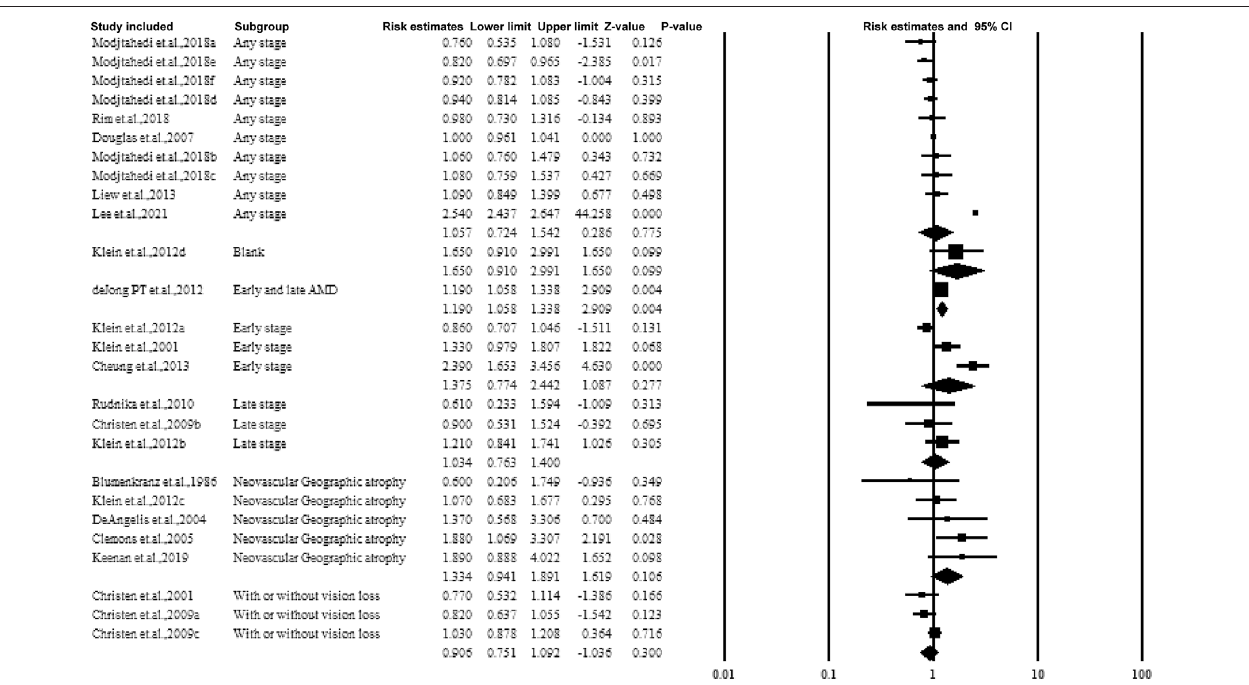
FIGURE 6 | Summarized subgroup analysis according to the stage or classi fi cation of AMD.